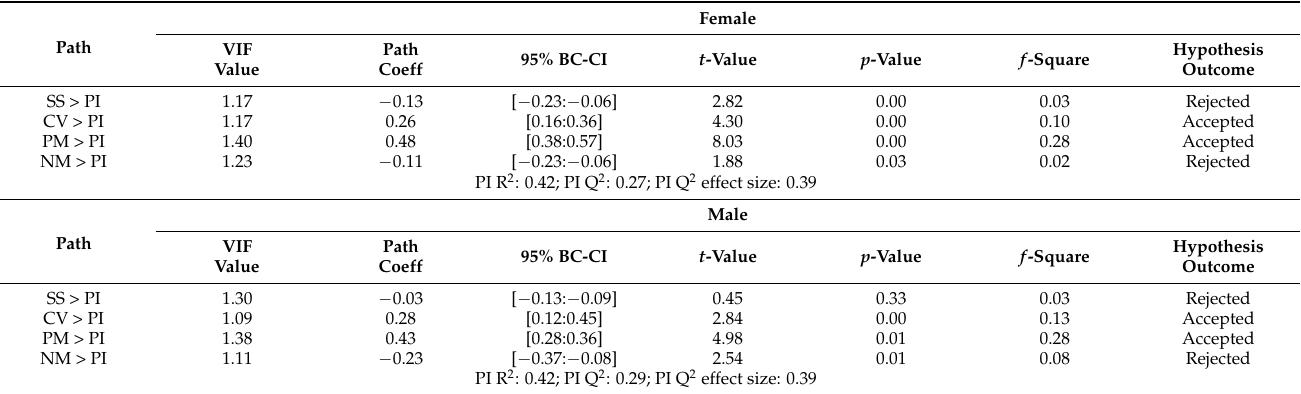
Table 5. Structural Model Result controlled by